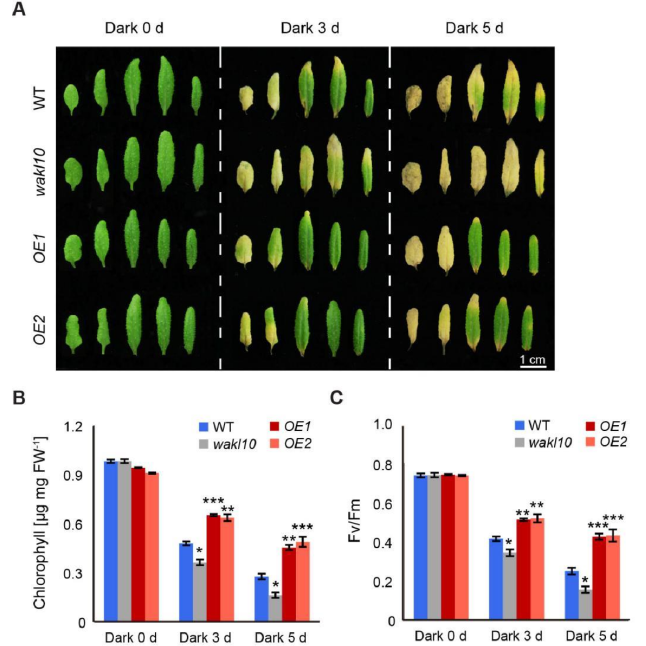
Figure 6. AtWAKL10 delayed dark-induced senescence in detached leaves. ( A ) Representative images of detached leaves 3, 4, 5, 6, and 7 from 25-day-old plants of tested genotypes before and after a 3 d and 5 d of darkness acclimation. Leaves were placed on moistened filter papers in foil-wrapped Petri dishes and collected at indicated time points for measurements of chlorophyll concentrations ( B ) and photosynthetic efficiency (Fv/Fm) ( C ). Error bars showed the SE ( n = 5). Significant differences compared with the wild type at each time point were determined by a Student’s t -test (* p < 0.05, ** p < 0.01, and *** p < 0.001). Three independent experiments were carried out with similar results.